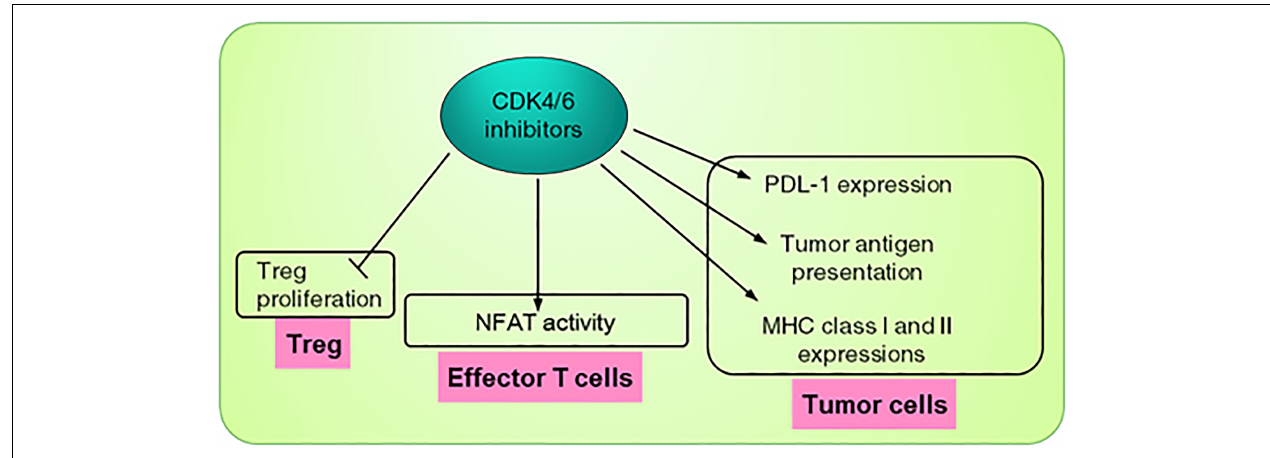
FIGURE 3 | Roles of CDK4/6 inhibitor in tumor immunosurveillance. CDK4/6 inhibitor exerts tumor immunomodulation via 3 types of cells. In tumor cells, the inhibitor promotes expression of PDL-1, causing the tumor to be vulnerable to the immune checkpoint inhibitor (ICI). CDK4/6 inhibitor also promotes expression of MHC I/II and increases tumor antigen presentation. In effector T cells, CDK4/6 inhibitor increases activity of NFATs, key regulators of T-cell development and function. Lastly, CDK4/6 inhibitor indirectly promotes immune function by inhibiting Treg